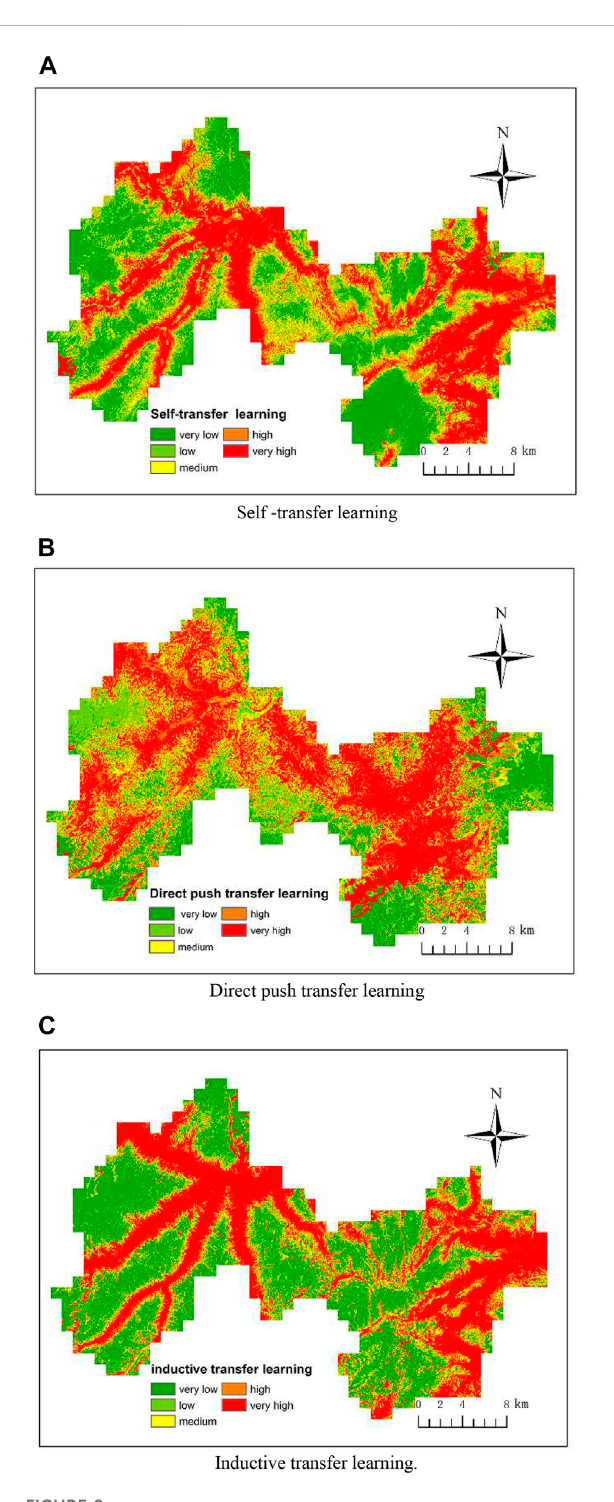
FIGURE 8 Landslidesusceptibilitymapsusingthethreemodels. (A) Self-transfer learning, (B) Direct push transfer learning, (C) Inductive transfer